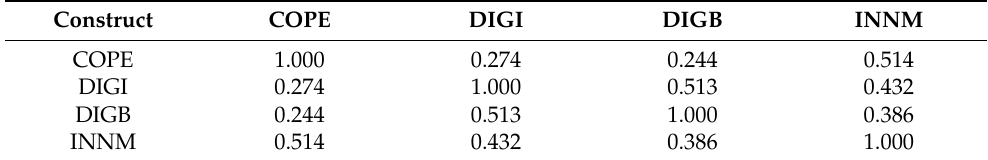
Table 2. Correlation matrix of the